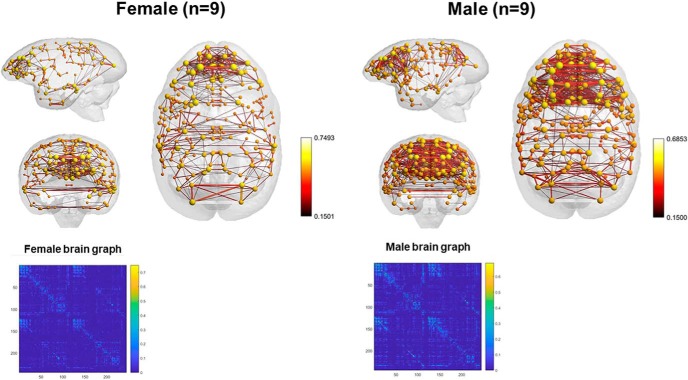
3D functional network maps of the marmoset monkey brain display increased clustering in the males relative to females. Shown are sagittal, coronal, and axial views of nodes (spheres) and edges (connecting lines) overlaid onto a 3D atlas map shell. Maps are thresholded at z > 0.2 and maps represent the top 10% of connections (density k = 0.10). The matrices below are mean functional connectivity matrices for male and female brains and their randomly rewired versions with the same density and edge weights and randomly assigned connections.